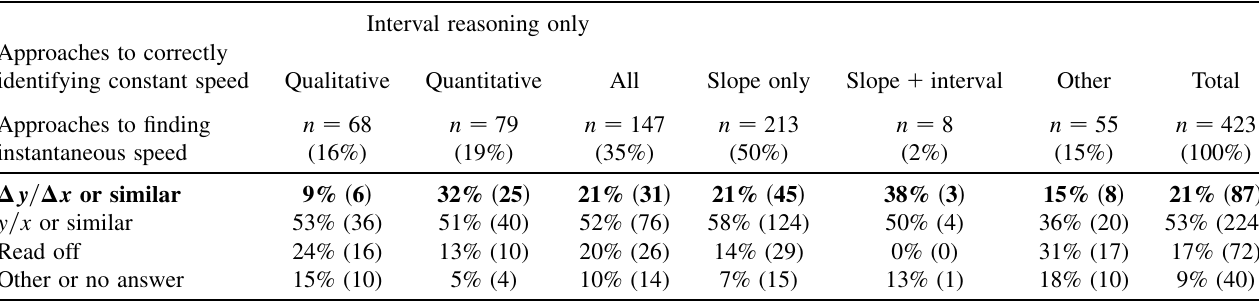
TABLE II. Pretest results linking the reasons students gave for correctly identifying constant speed with how they determined a value for the rate of change at one particular instant. For example, the fourth column shows that of the 147 students (i.e., 35% of all students who identified that the speed was constant) who used interval reasoning to determine that the speed changes at constant rate in the pretest, 21% correctly determined the rate of change using a correct method, 52% divided the two coordinates, 20% read off the value, and 10% gave uncategorized answers or no answers.